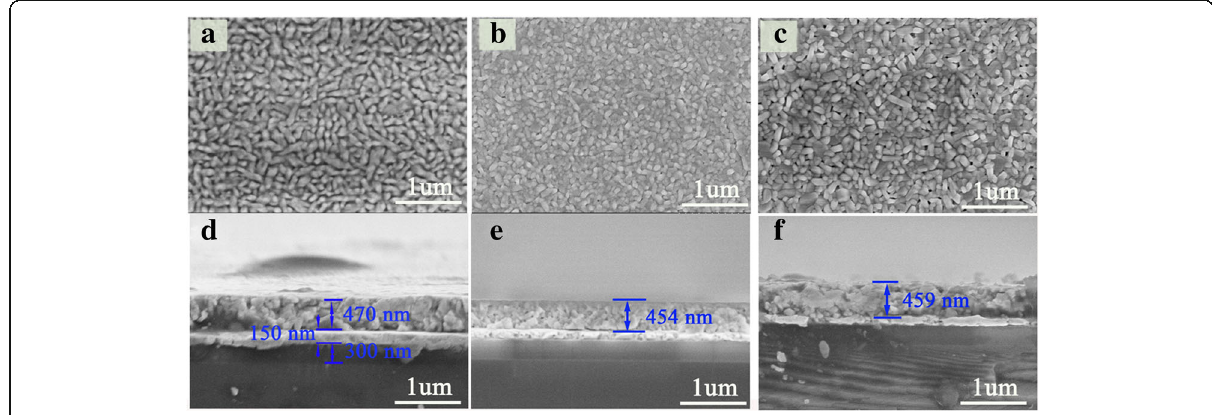
Fig. 2. SEM surface and cross-section images: a , d BNTM-1; b , e for BNTM-2; c , f for